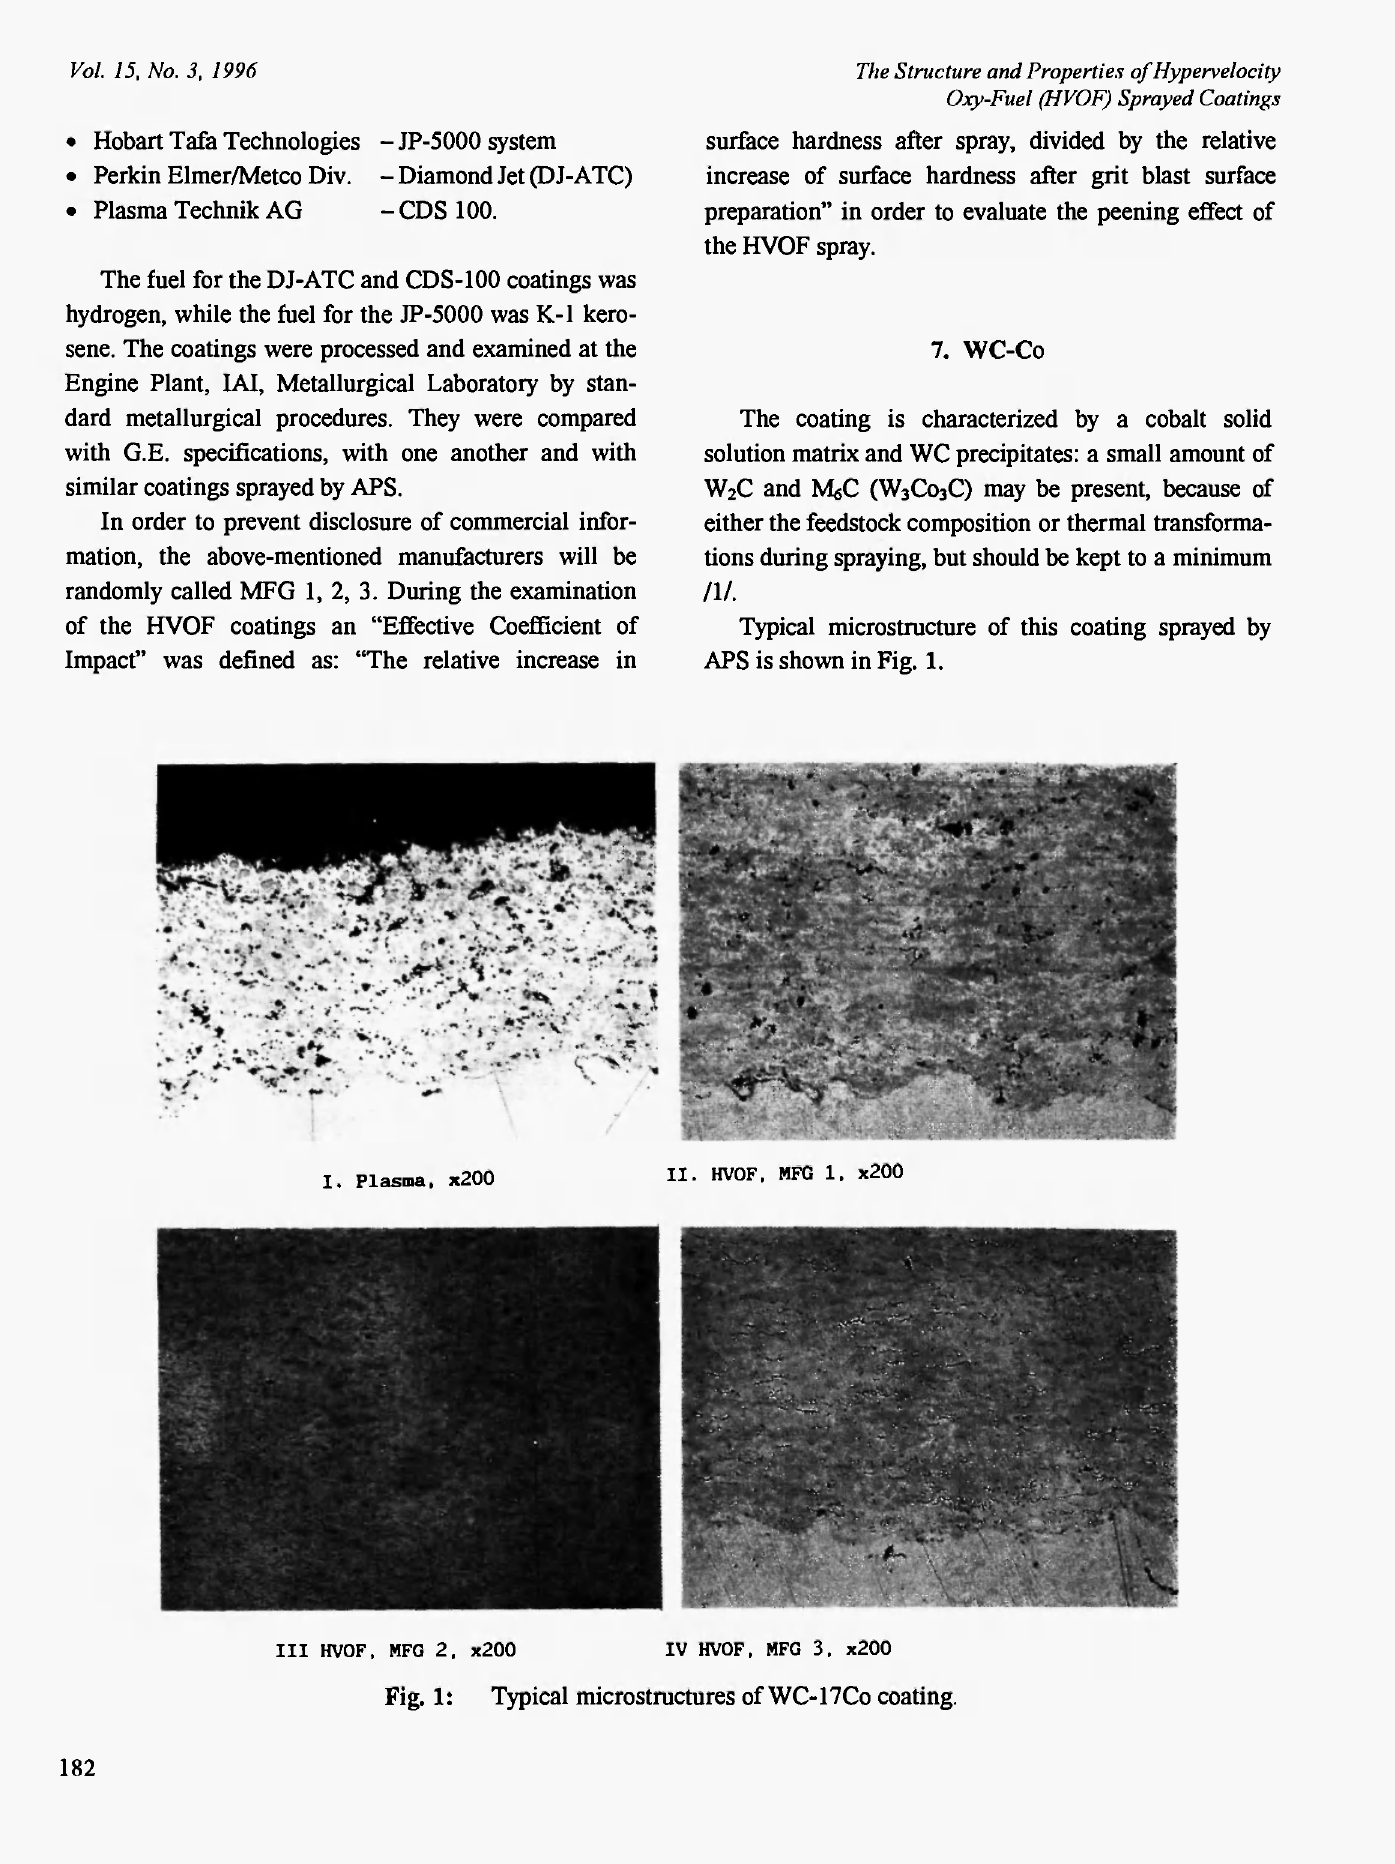
Fig. 1: Typical microstructures of WC-17Co